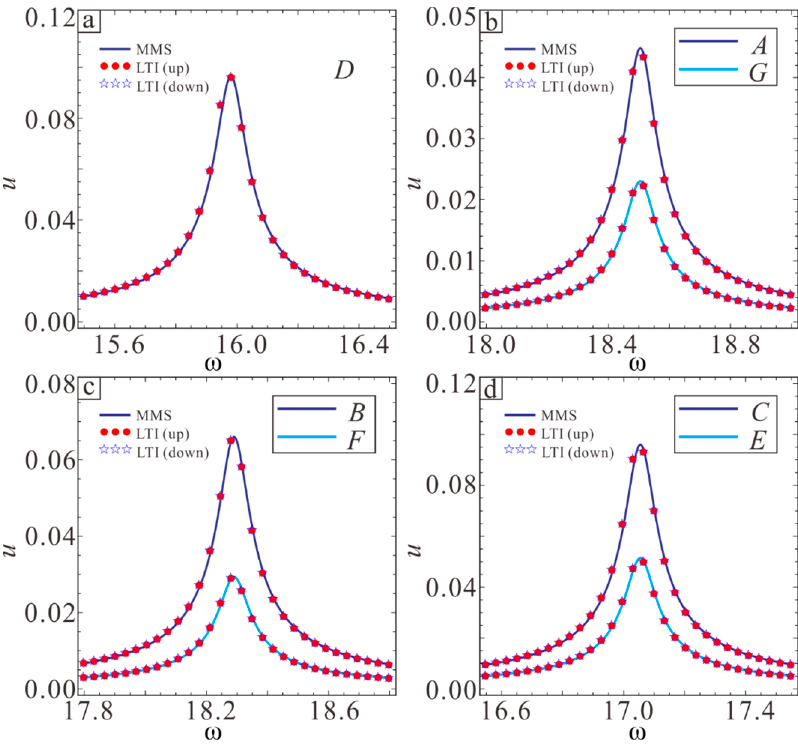
Figure 12. Frequency response curves for A , B , C , D , E and F cases: ( a ) the case of D ; ( b ) the cases of A and G ; ( c ) the cases of B and G ; ( d ) the cases of C and E .